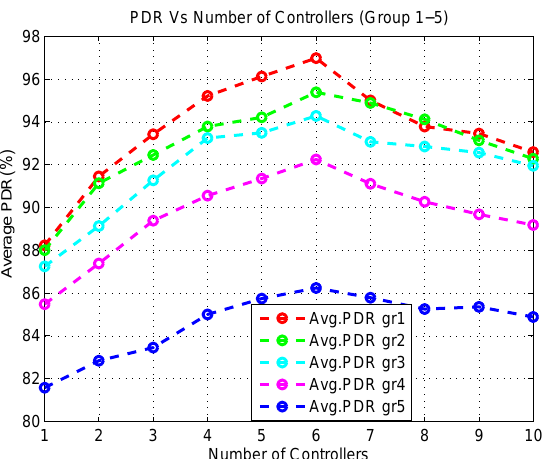
Figure 6. Average PDR with varying number of controllers.